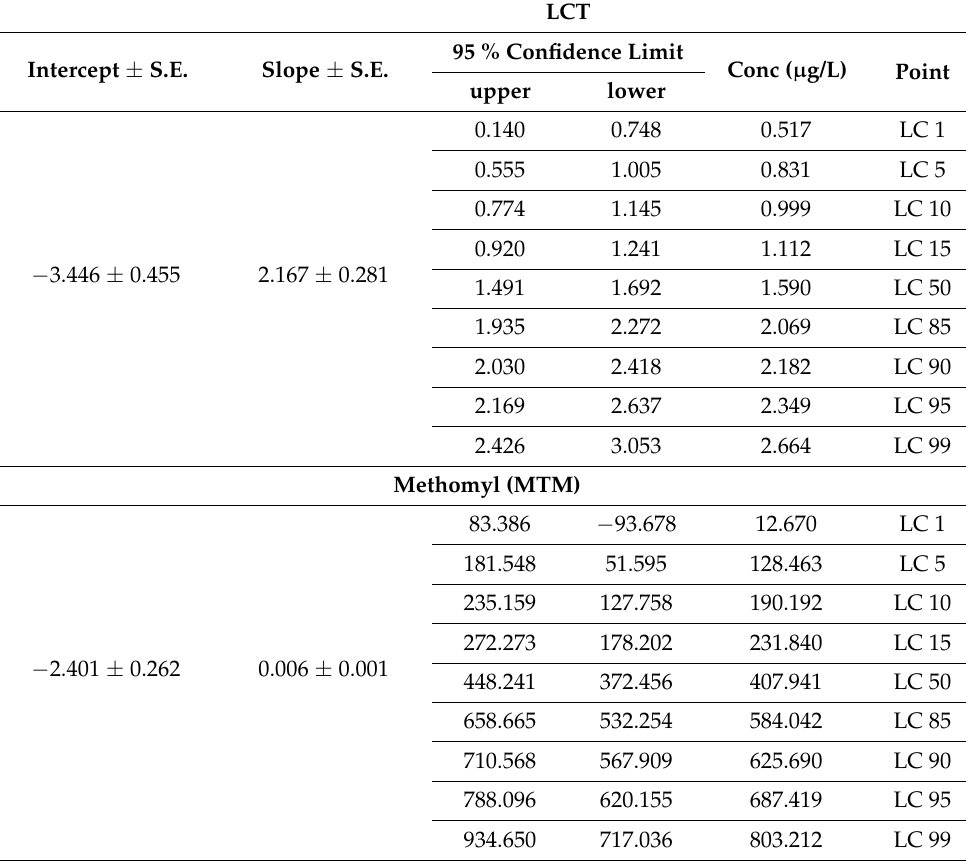
Table 2. Acute 96-h toxicity of lambda-cyhalothrin (LCT) and methomyl (MTM) in O . niloticus. Intercept ± S.E. Slope ± S.E.